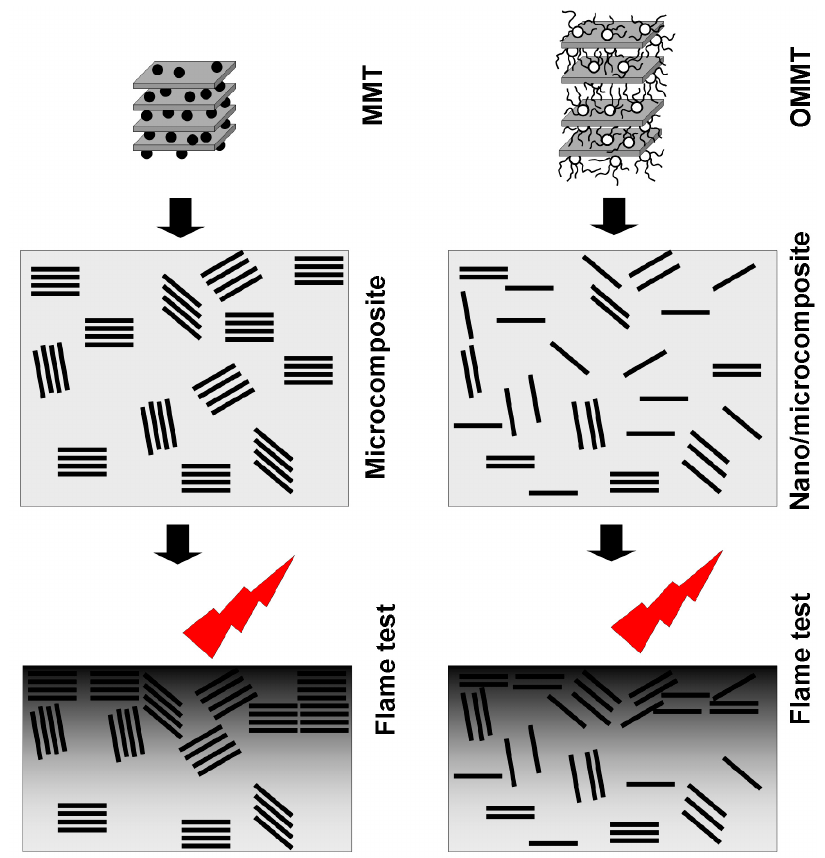
Figure 7. Schematic structures of PE nano/microcomposites containing MMT (C–Ca) or organophilised montmorillonite (OMMT) (CW9) (before and after LOI tests).